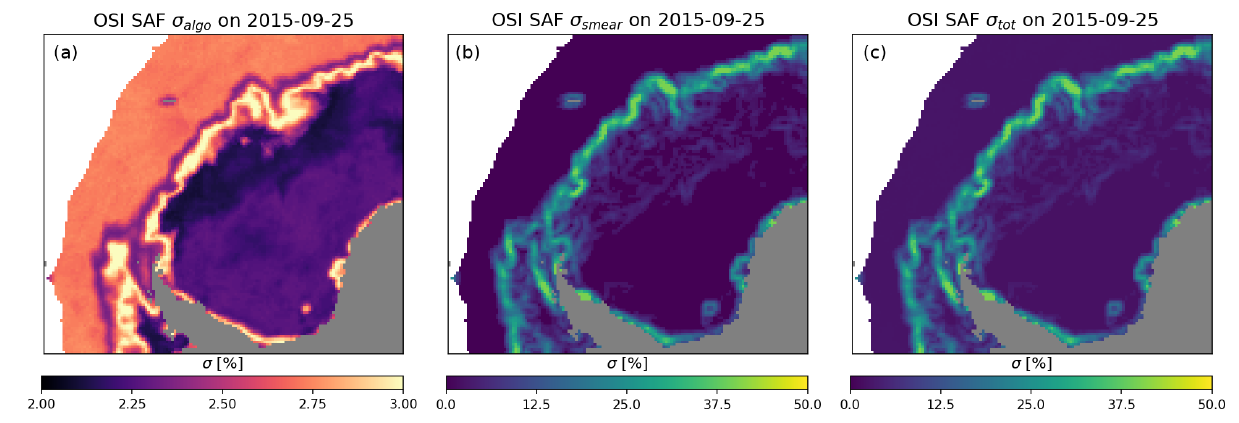
Figure 7. Example fields of uncertainties on 25 September 2015 from the EUMETSAT OSI SAF CDR over the Weddell Sea. The component σ algo (a) , σ smear (b) , and the total uncertainty σ tot (c) are shown. σ tot is dominated by the σ smear